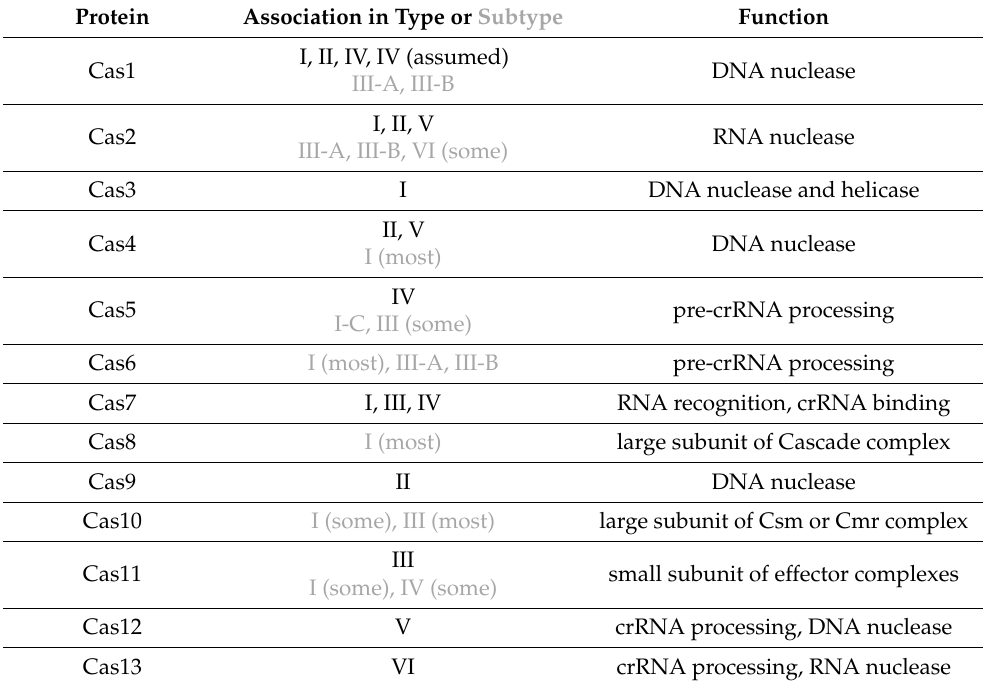
Table 1. Selected Cas proteins and their functions. Types (Roman numerals) are colored black, and subtypes (Roman numerals with a letter) are colored gray [14,21].